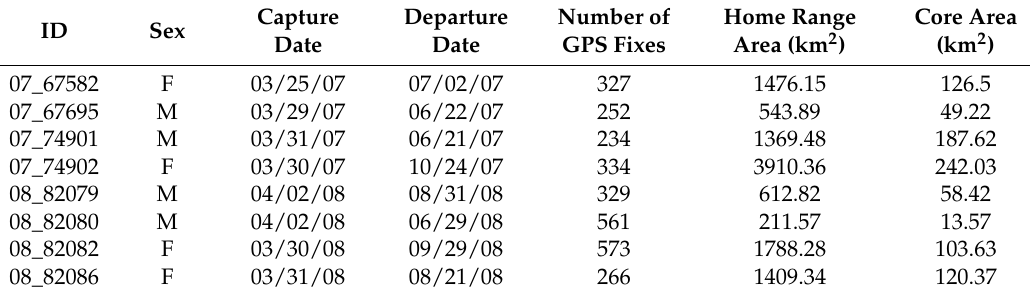
Table 1. ID number, sex, capture and departure dates, number of satellite GPS locations, and home range and core area size for Bar-headed Geese ( Anser indicus ) marked and satellite-tracked at Qinghai Lake.